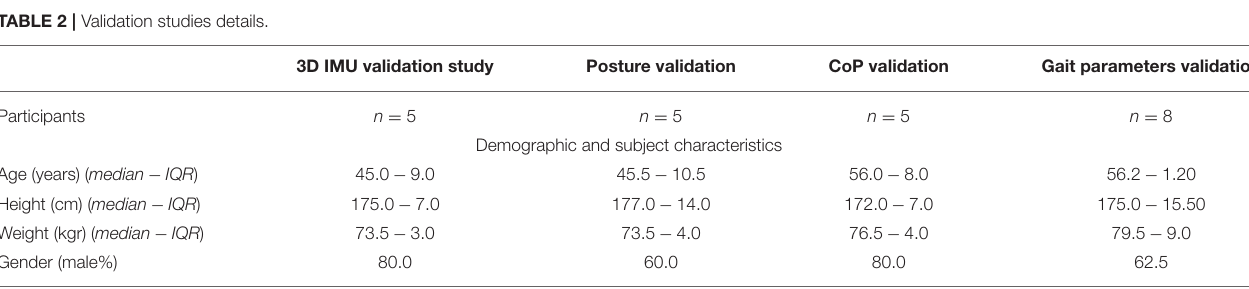
TABLE 2 | Validation studies